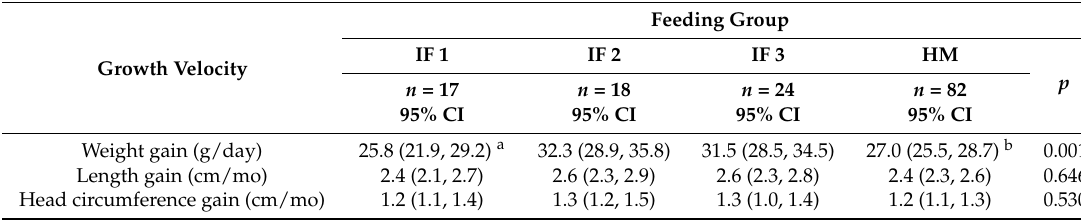
Table 4. Gains in weight, length, and head circumference of infants by feeding group from 1 to 4 months of